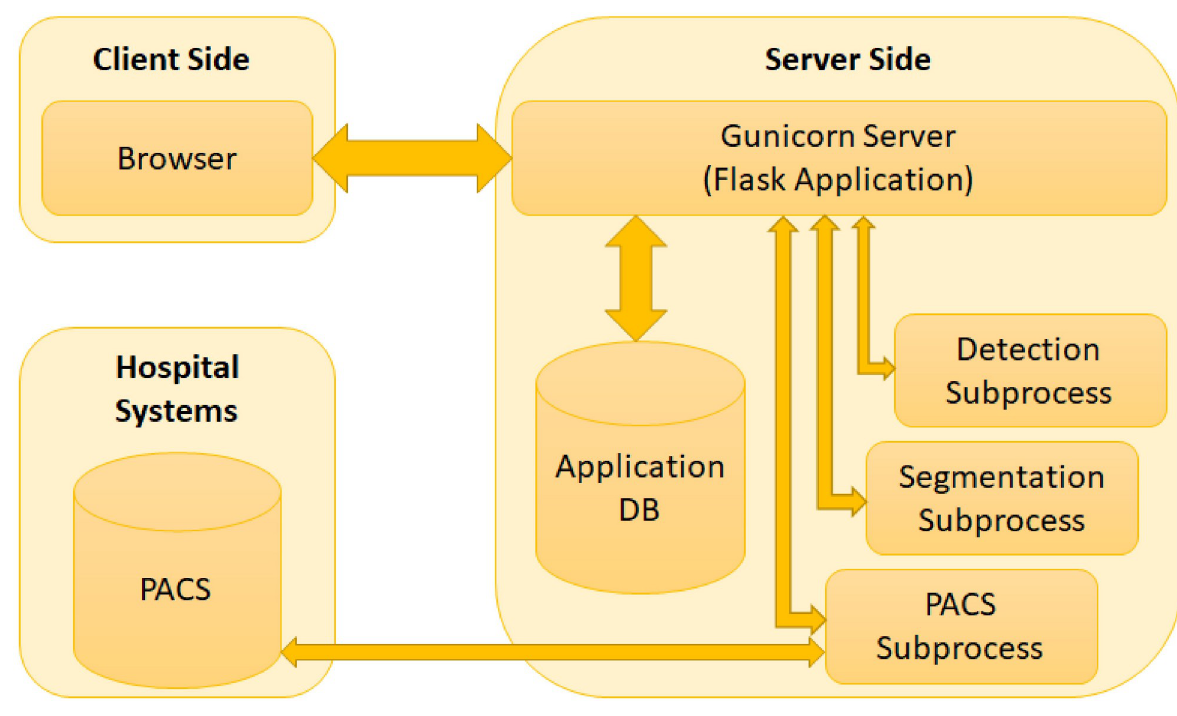
Fig 7. Web application